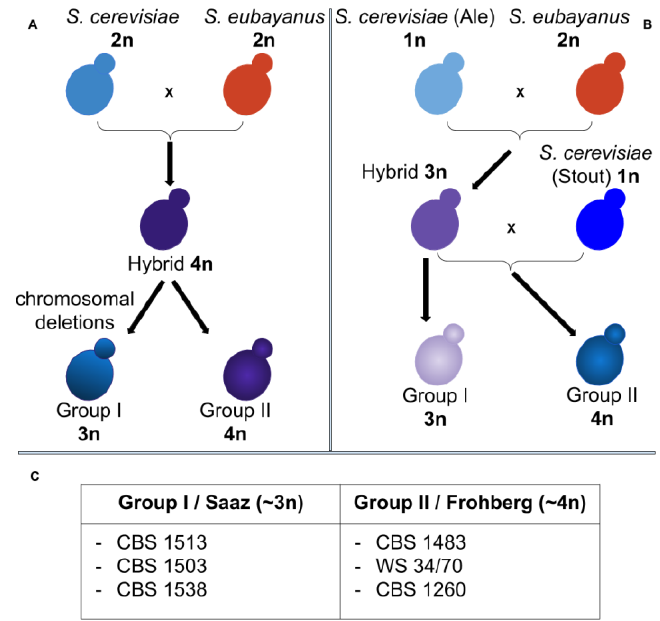
Figure 1. Proposed origins of Group I and II Saccharomyces pastorianus . ( A ): A hybridization event occurred between a diploid S. cerevisiae and a diploid S. eubayanus , followed by a di ff erent amount of genome reduction. ( B ): A hybridization event between a haploid S. cerevisiae and a diploid S. eubayanus lead to a triploid progenitor. Subsequently, a second hybridization event occurred between the triploid progenitor and a haploid S. cerevisiae . ( C ): Strains belonging to the Group I and II (adapted from Alsammar et al . , 2020).